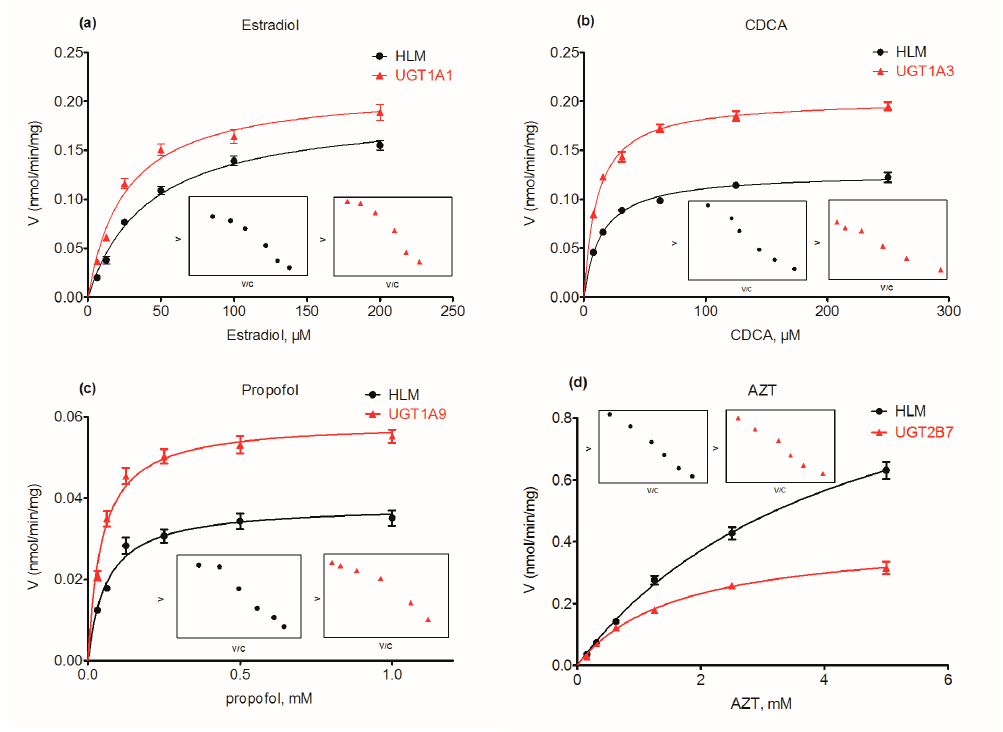
Figure 4. Kinetic profiles for β -estradiol ( a ), chenodeoxycholic acid (CDCA) ( b ), propofol ( c ) and zidovudine (AZT) ( d ) glucuronidation by pooled human liver microsomes (HLM) and individual UGTs enzymes; in each panel, the insert figure shows the corresponding Eadie–Hofstee plot. All experiments were performed in triplicate. Data are expressed as the mean ± SD.